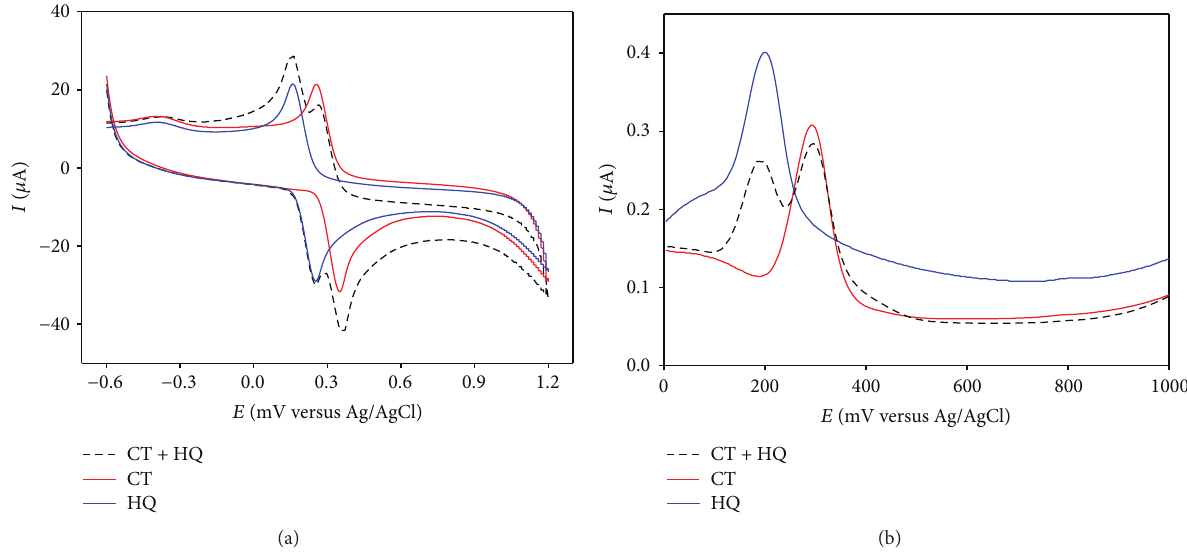
Figure 2: Overlay of (a) CV and (b) DPV responses of individual (solid lines) and binary mixture (dashed line) of CT and HQ in PBS at PGA modified GCE.